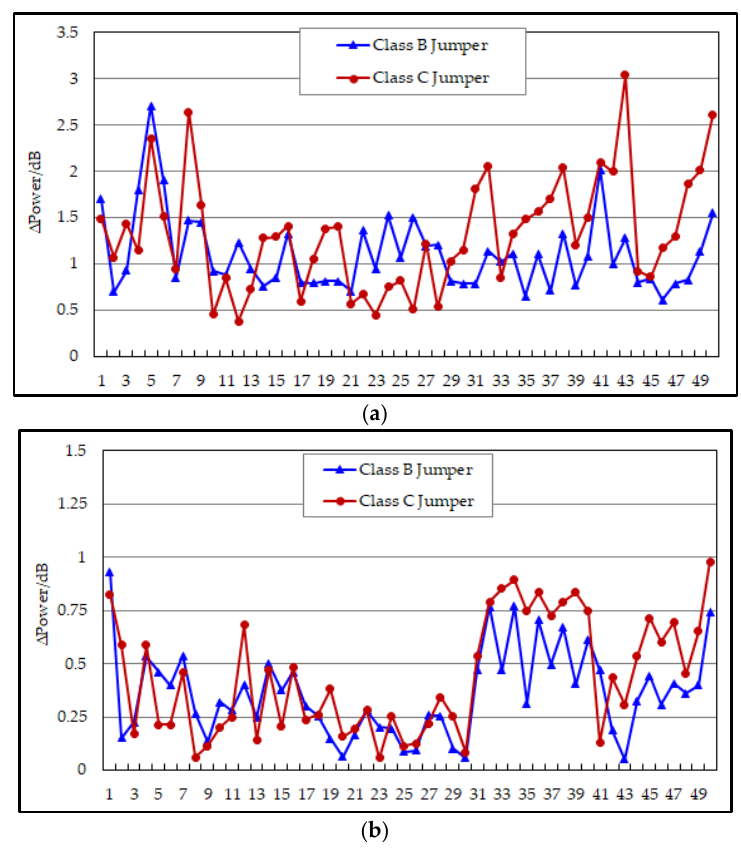
Figure 11. ( a ) is the distribution of four-direction data with 2D coupling model. ( b ) is the distribution of four-direction data with 3D defocusing coupling model. The horizontal axis represents the serial number of samples, and the vertical axis represents the power changing.